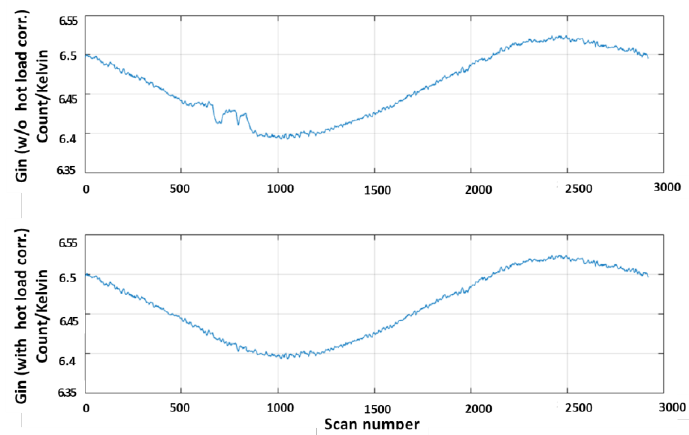
Figure 6. The calculated gain for channel 10.65 V with ( bottom panel ) and without ( upper panel ) hot load correction (orbit #87736).